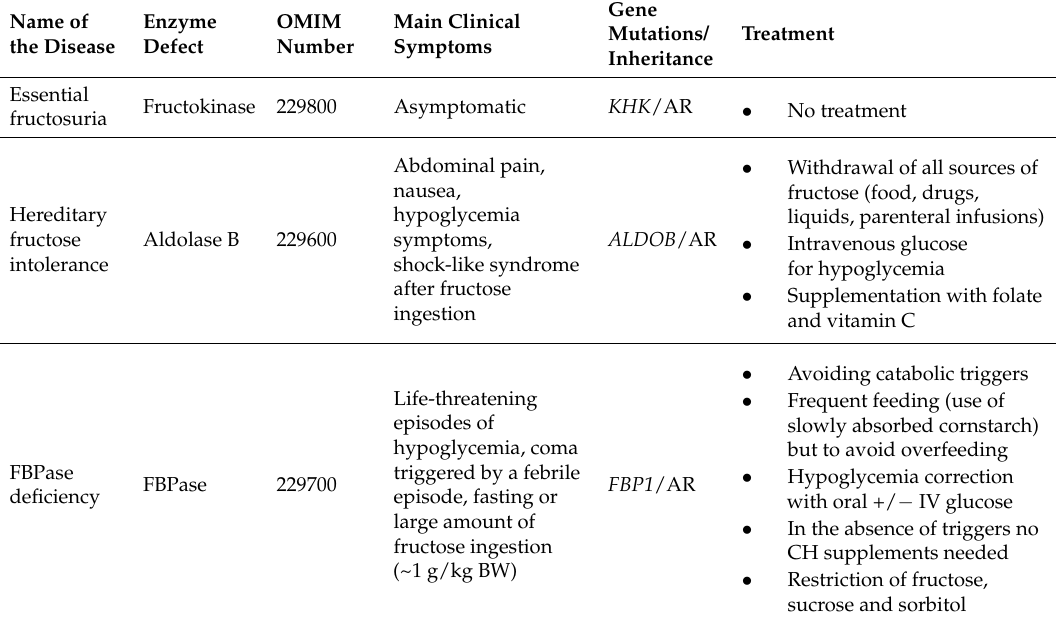
Table 1. Summary of enzyme defect, main clinical symptoms, and treatment of inborn errors of fructose